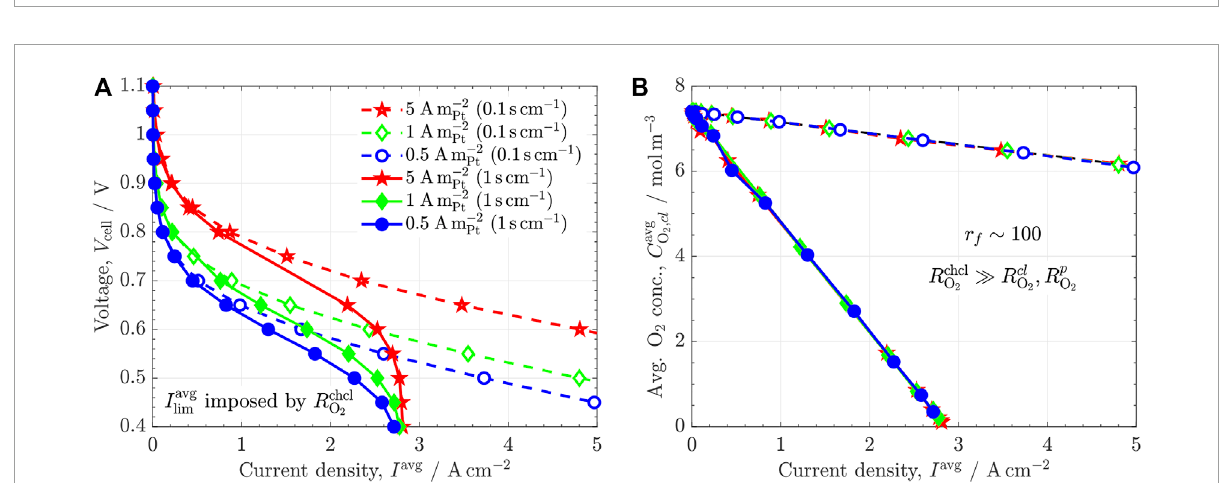
= 1 s cm −1 , and (B) optimized 2